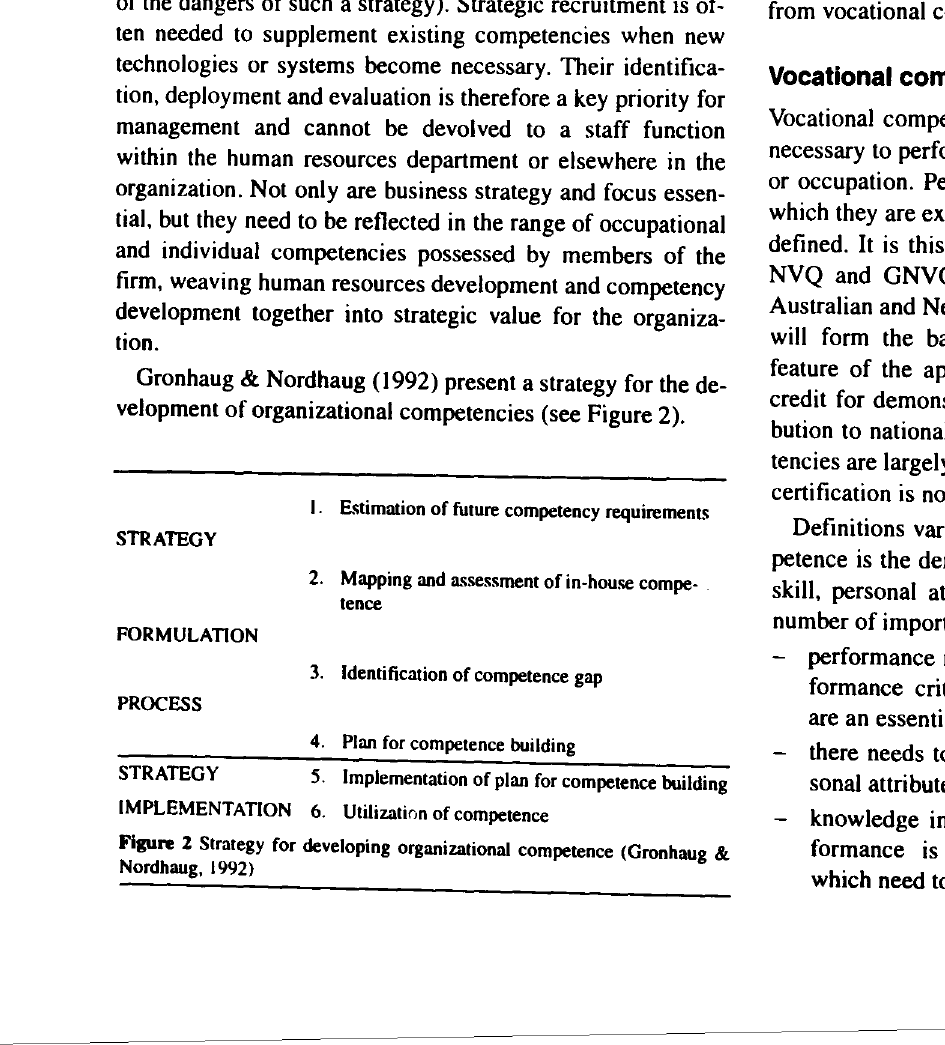
Figure 2 Strategy for developing organizational competence (Gronhaug & Nordhaug,